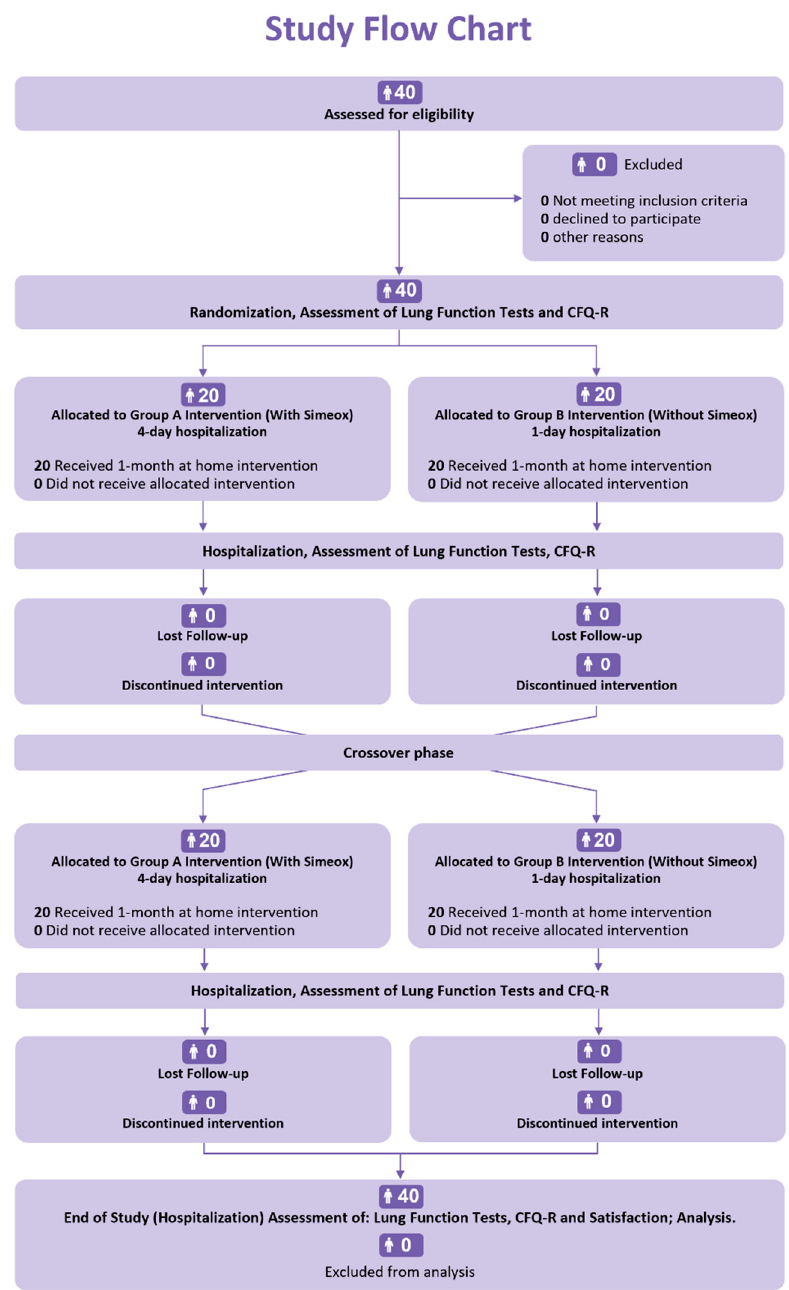
Figure 1. Timeline of the